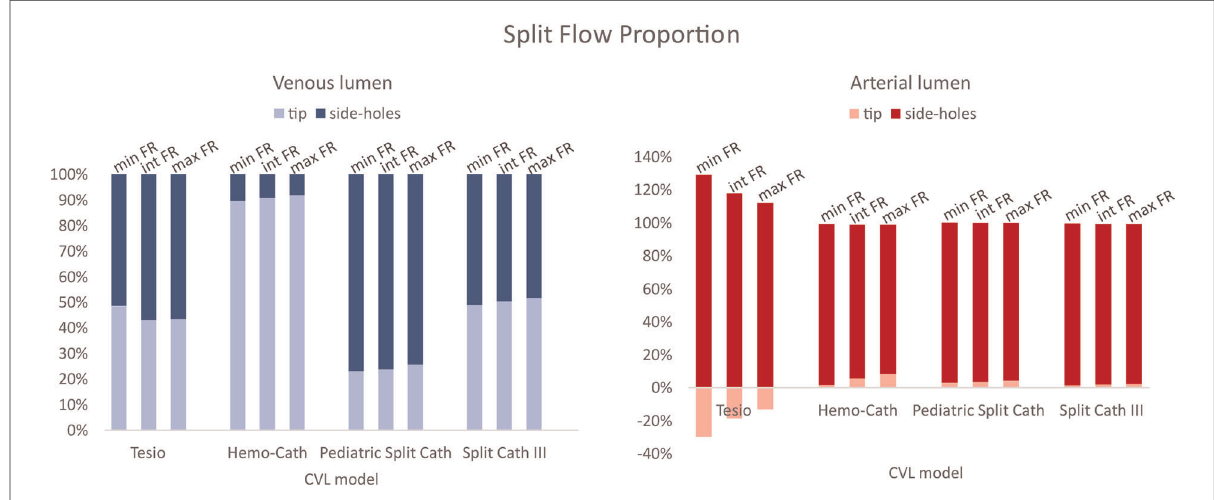
FIGURE 4 Split fl ow proportion between the tip and the side-holes for both lumens (venous and arterial). CVL=Central venous line; FR=Flow